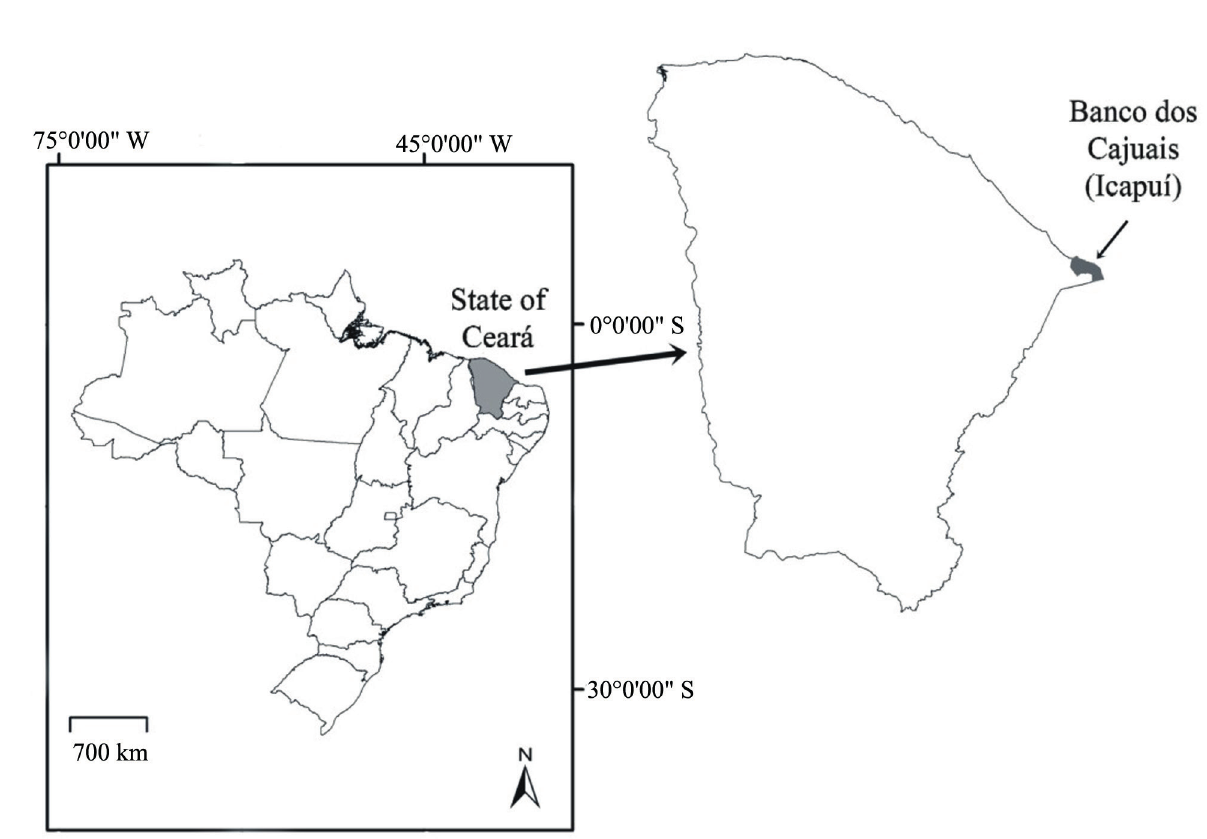
Figure 1. Location of the sea grass meadow (Banco dos Cajuais), on the east coast of the state of Ceará, northeastern